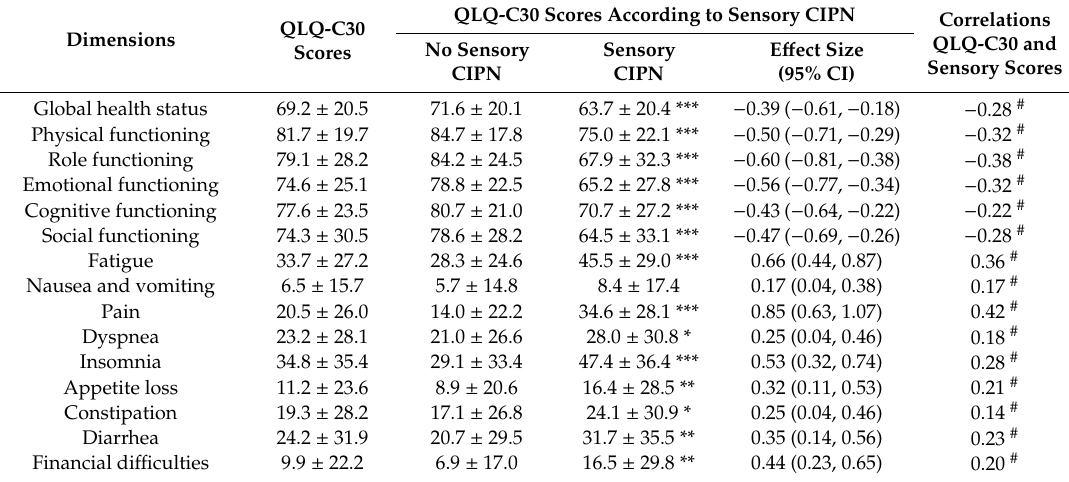
Table 3. Comparison of QLQ-C30 score according to sensory CIPN and correlation between QLQ-C30 score and QLQ-CIPN20 sensory score. The correlations between the QLQ-C30 score and QLQ-CIPN20 sensory score are presented with the correlation coe ffi cient and significance.